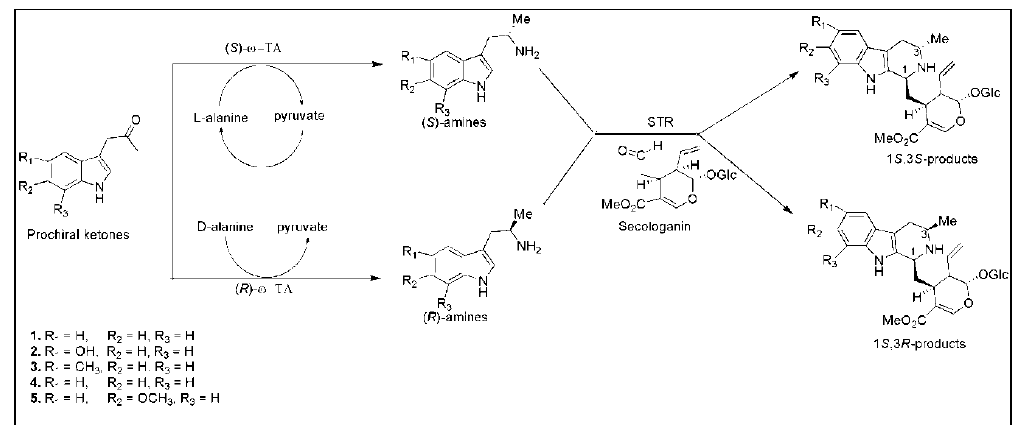
Figure 10. Biocatalytic cascade employing ω -TA and STR for the chemo-enzymatic synthesis of C3-methyl-substituted enantiopure Strictosidine derivatives (adapted with permission from [119], Copyright (2015) American Chemical Society). (Reaction conditions: 2 mM substrate, potassium phosphate buffer (100 mM, pH 7.0), 10 mg lyophilized E. coli cells over-expressing ω -TA, 90 mU